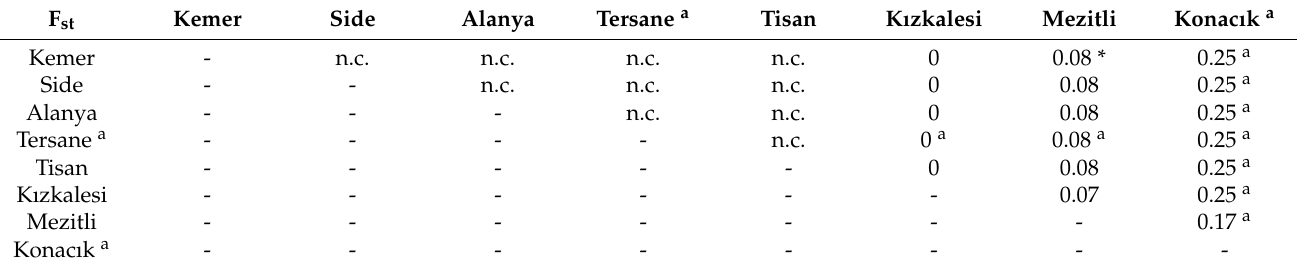
Table 3. Genetic differentiation (F st ) between the spatial populations. The statistical significance for F st is indicated. a : These groups have small population sizes ( n < 10). Statistical significance: